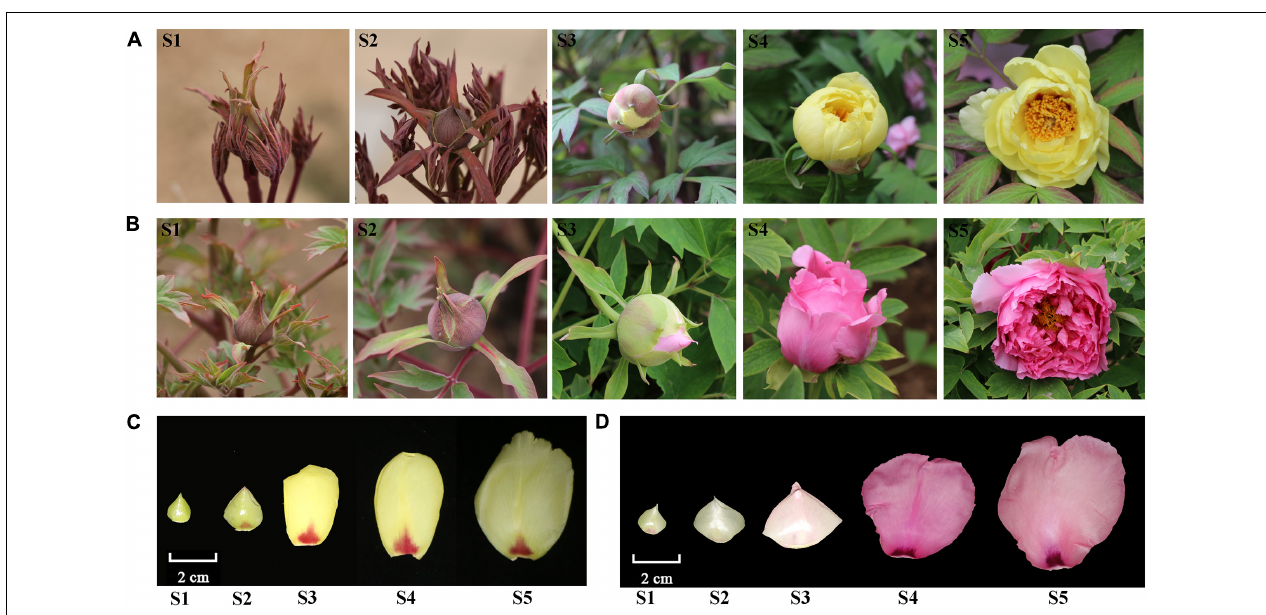
FIGURE 1 | Flowers of two tree peony cultivars “High Noon” and “Roufurong” at five blooming stages. (A,C) “High Noon.”. (B,D) “Roufurong.” S1: Stage 1, unpigmented tight bud; S2: Stage 2, slightly pigmented soft bud; S3: Stage 3, initially opened flower; S4: Stage 4, half opened flower; S5: Stage 5, fully opened and pigmented flower with exposed